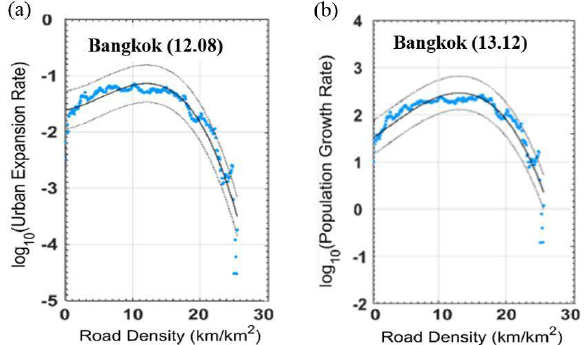
Figure 6. (a) Urban expansion rate and road density values and fitted using a third-order polynomial (upper/lower bounds in the fit indicate 90% confidence intervals). (b) As (a) but for population growth rate. Turning point values (km/km 2 ) are listed within parenthesis.